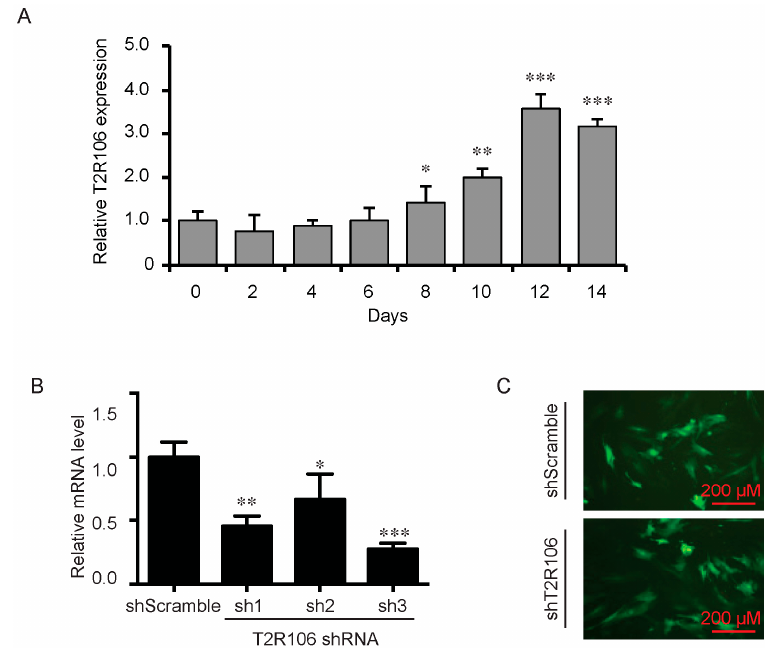
Figure 5. Expression and knockdown of T2R106 in mouse primary preadipocytes. ( A ) Expression of T2R106 during adipogenesis of mouse preadipocytes. Cells were induced for differentiation with MDI for 14 days, total RNA was isolated and used for detection of T2R106 mRNA expression levels with qRT-PCR (mean ± SEM; n = 6; two way ANOVA; * p < 0.05, ** p < 0.01, *** p < 0.001, indicated fold change compared with Day 0); ( B ) Knockdown efficiency of T2R106 in mouse primary preadipocytes was assessed with qRT-PCR after 48 h infection (mean ± SEM; n = 6; two way ANOVA; * p < 0.05, ** p < 0.01, *** p < 0.001, indicated fold change compared with control). Sh1, sh2 and sh3 represent T2R106 shRNA-1, shRNA-2 and shRNA-3 respectively. ShScramble represents scramble shRNA. T2R106 shRNA-3 was used for further experiments; and ( C ) Infection efficiency of T2R106 shRNA was indicated with GFP after 48 h